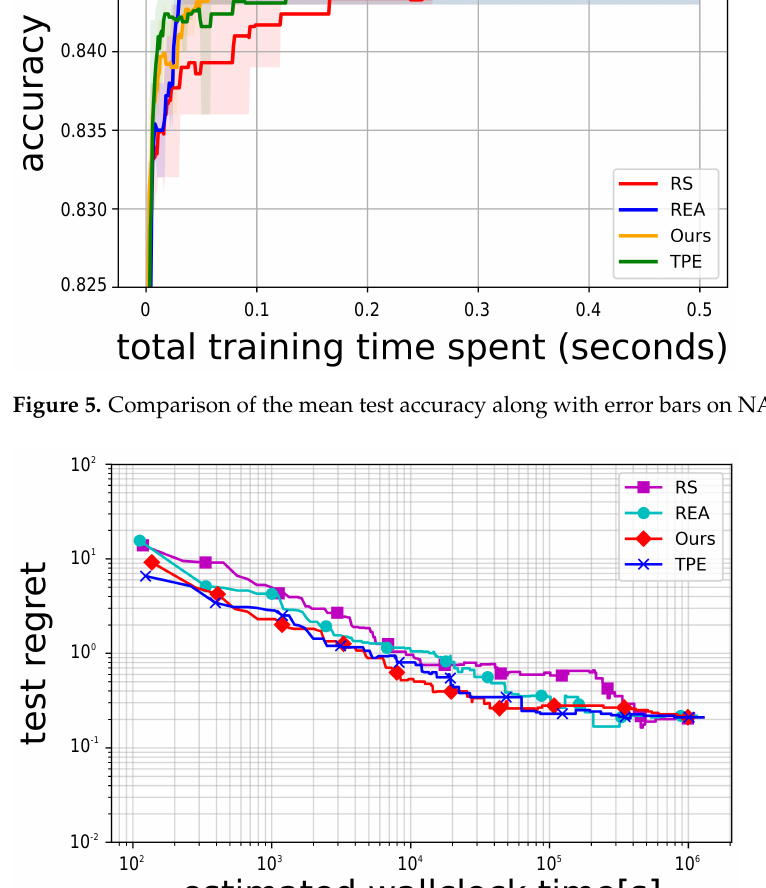
Figure 6. A comparison of the mean test regret performance of 500 independent runs as a function of estimated training time for NAS-Bench-201 on Cifar10